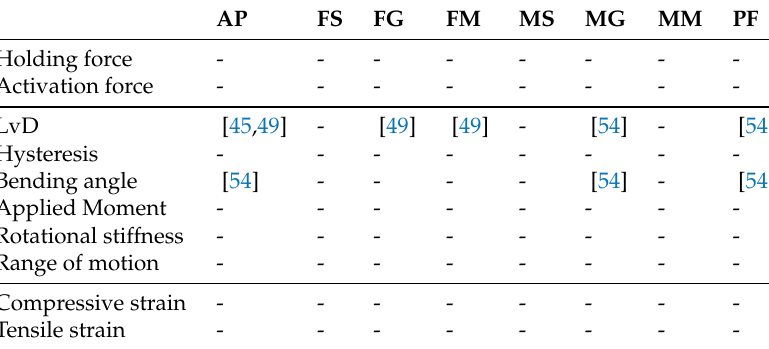
Table 12. Frequency of varying fibre jamming parameters per